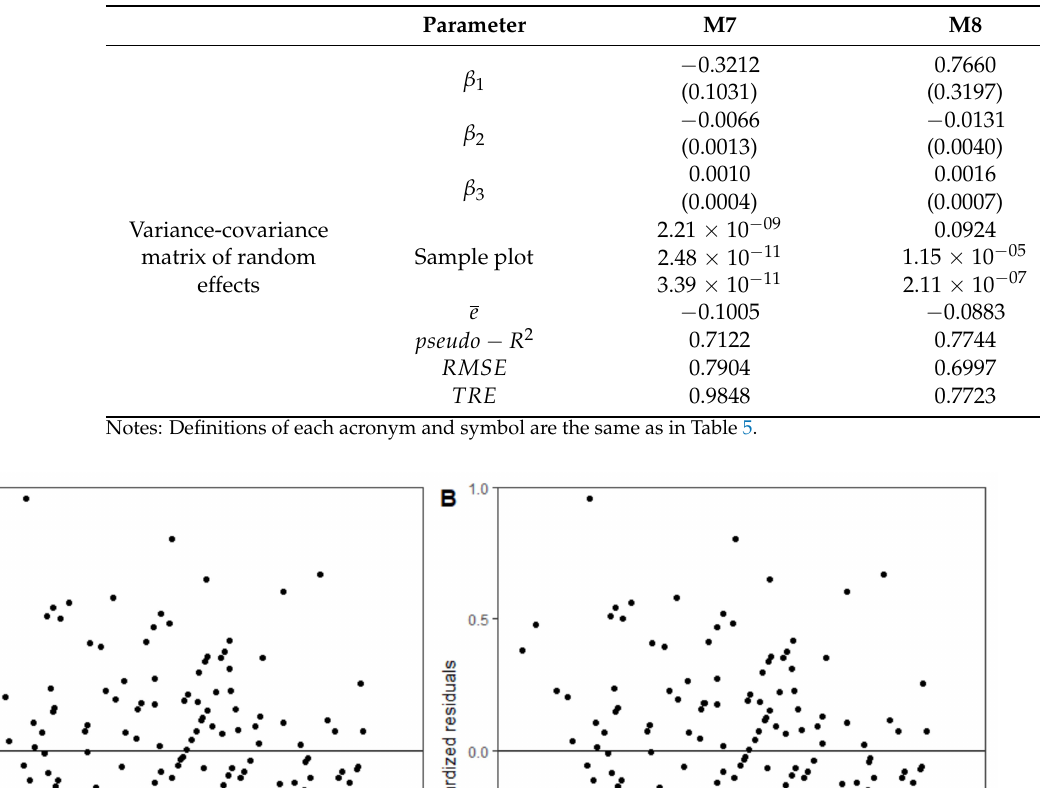
Table 7. Parameter estimates and fit statistics of the NLME HCB models.